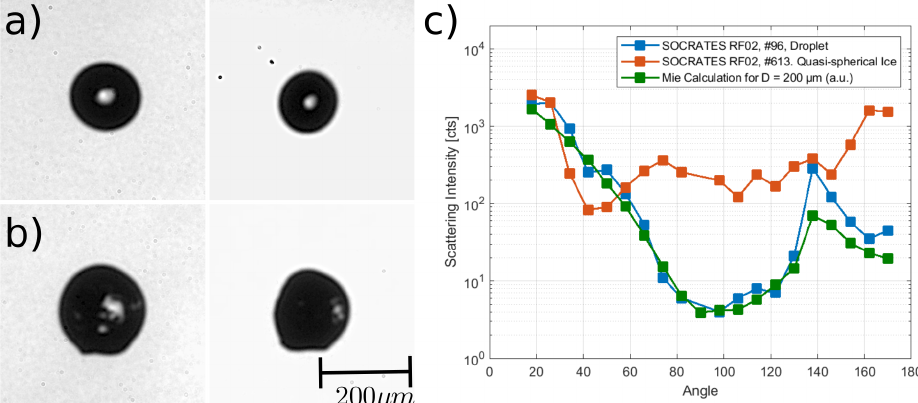
Figure 1. Stereo micrograph of a droplet (a) and a quasi-spherical ice particle (b) taken by the PHIPS probe. In the stereo micrograph, the two views of the particle have an angular distance of 120 ◦ . The instrument concurrently recorded the angular-light-scattering functions of the imaged particles as displayed in (c) . The theoretical scattering function calculated for a droplet with a diameter of 200µm calculated using the Mie theory is shown for comparison in (c) . The calculated scattering intensity is integrated over the field of view of each of PHIPS’ 20 polar nephelometer channels so it can be compared to the measurement (see Supplement Sect. S6 for details).